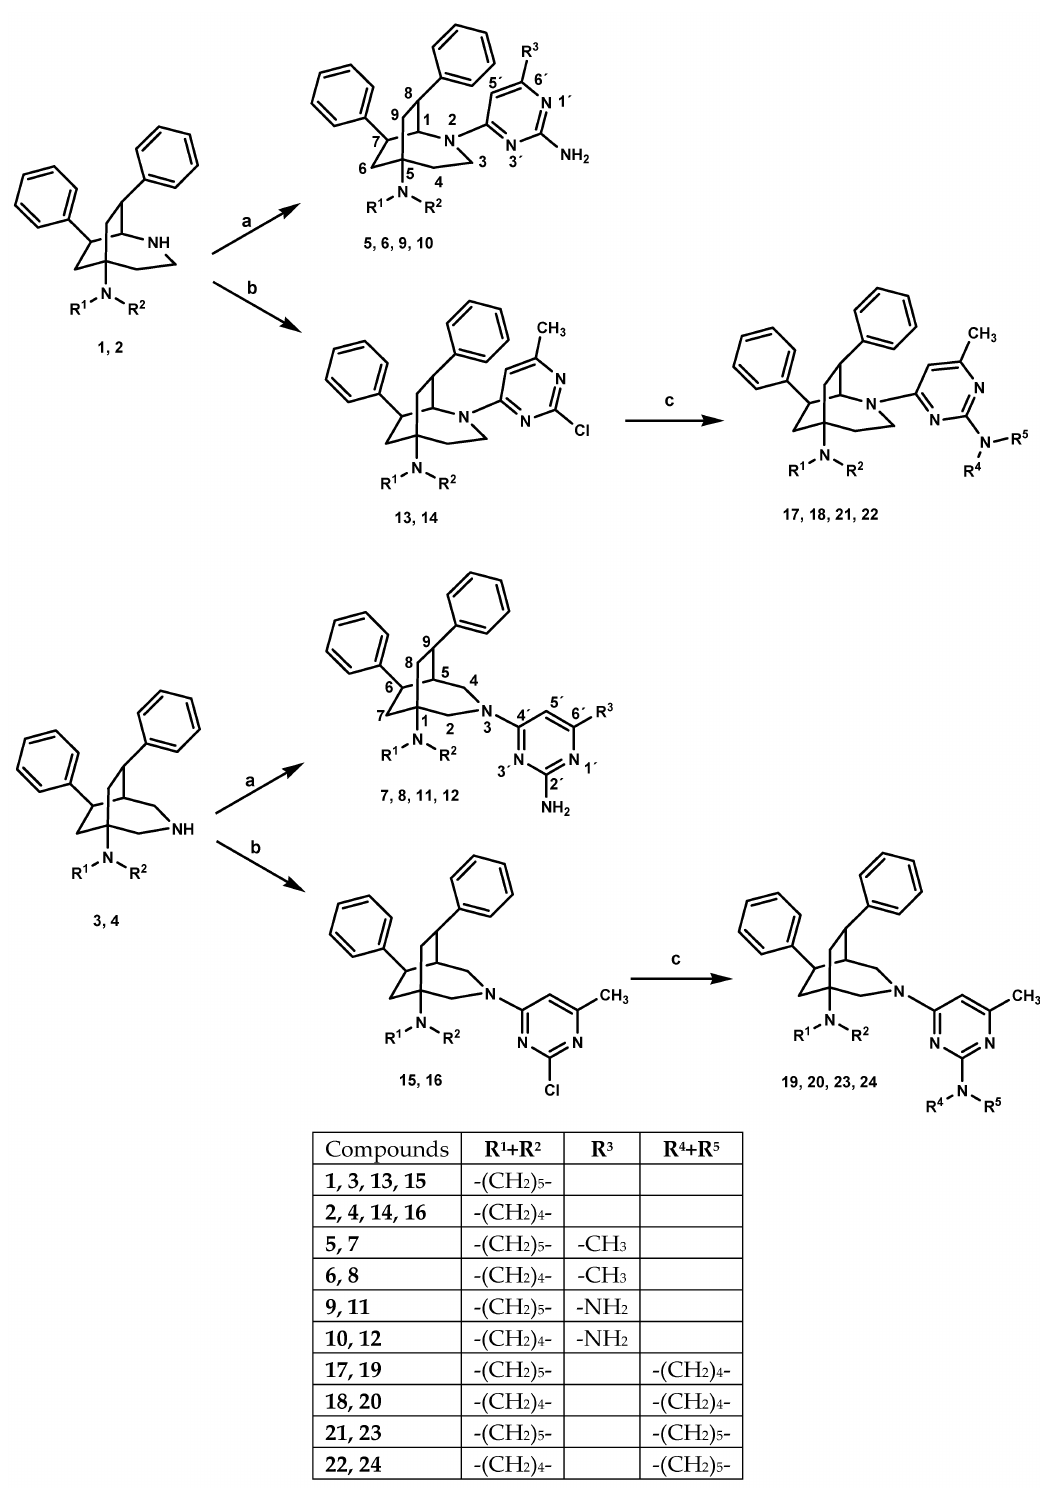
Scheme 1. Preparation of compounds 5 – 24 . Reagents and conditions: (a) corresp.